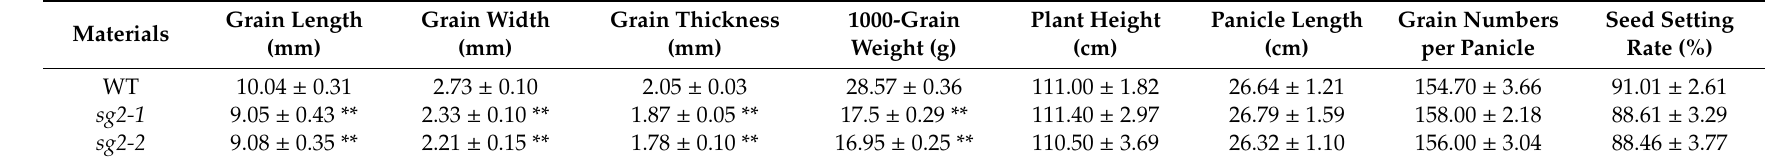
Table 1. Agronomic traits of WT and sg2